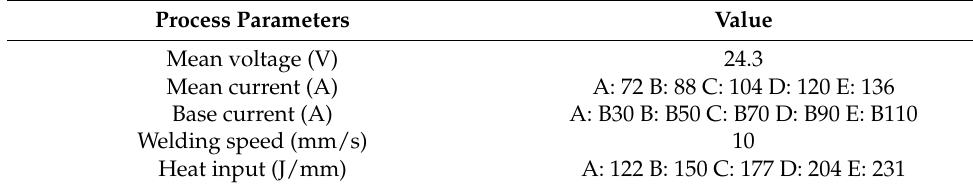
Figure 1. Schematic of ( a ) experimental setup and ( b ) the adjustment of average current. Table 2. Welding process parameters for P-GMAW. Table 2. Welding process parameters for P-GMAW.